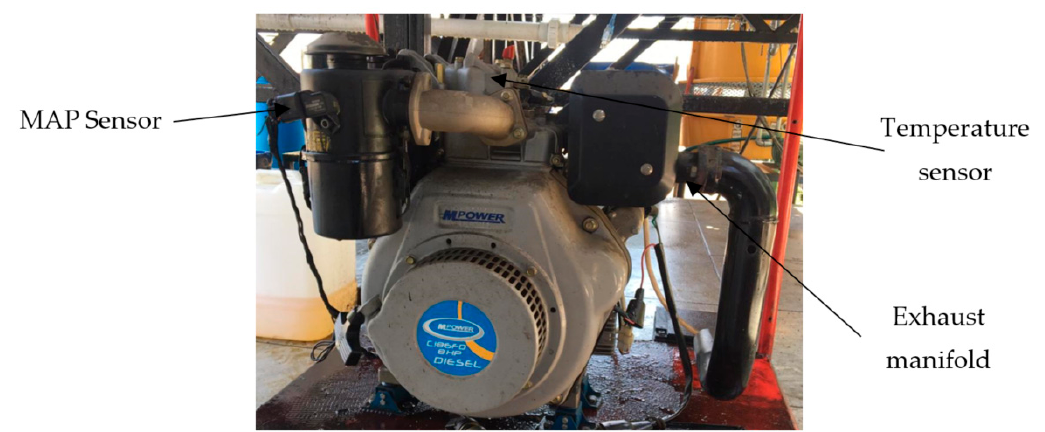
Figure 1. Mpower cylindrical mono diesel engine.